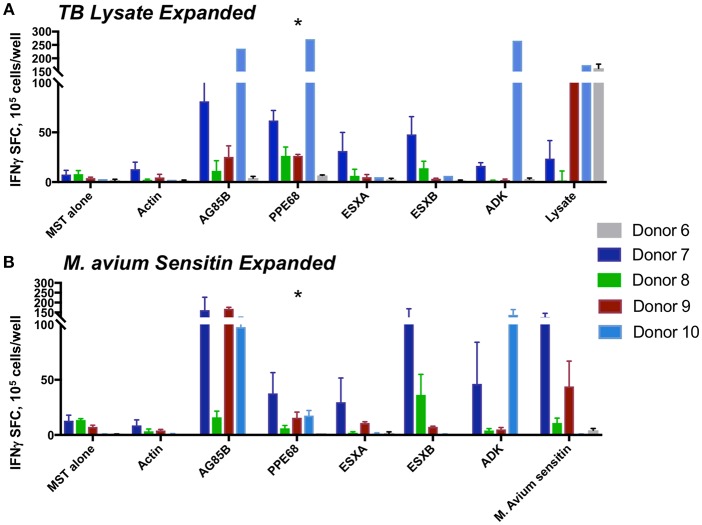
MST responses are comparable using peptide stimulation vs. lysate or sensitin. IFN-γ ELISpot from MSTs expanded using TB lysate (A) or M avium sensitin (B) showed specificity to multiple mycobacterial pepmixes, which were comparable in magnitude to the response to restimulation with lysate or sensitin. Differences in responses were only significant for PPE68 (*p = 0.032). SFC, spot forming colonies; SEB, staphylococcal enterotoxin B.